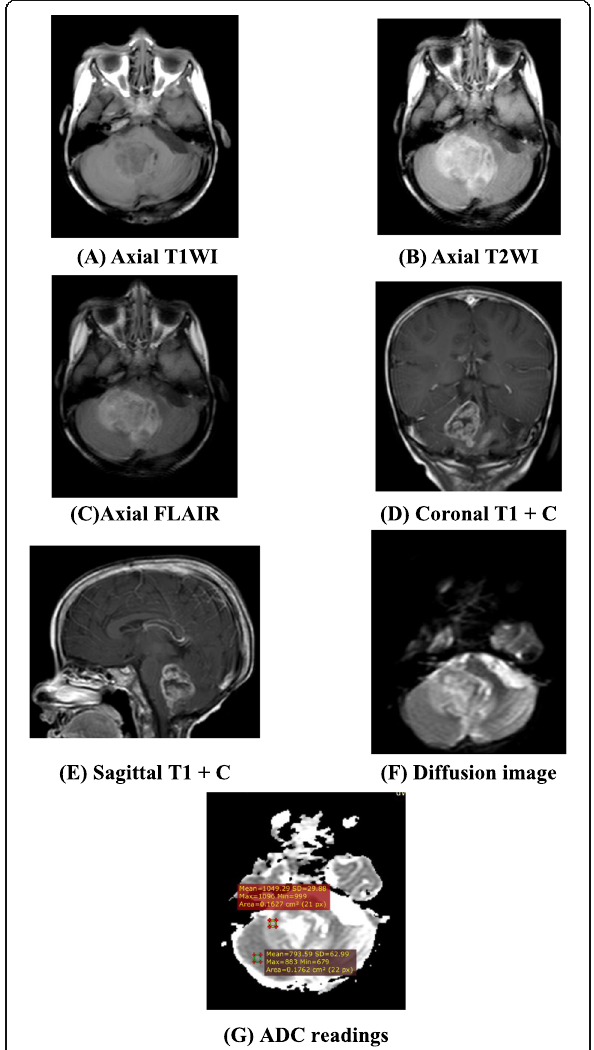
Fig. 6 An 8-year-old female patient complaining of vomiting. Axial T1 ( a ), axial T2 ( b ), axial FLAIR ( c ), coronal T1 post-contrast ( d ), sagittal T1 post-contrast ( e ) — posterior fossa intraventricular SOL seen filling the fourth ventricle and extending to the right cerebellum and left occipital lobe, measured 36 × 60 × 34 mm at its AP, width, and CC diameters. It showed heterogeneous predominantly low T1 SI ( a ), high SI at T2 WI ( b ), and FLAIR sequence ( c ) with cystic component, avid, and heterogenous enhancement after IV contrast injection ( d ), ( e ). Axial DWI ( f ), Axial ADC ( g ) — the lesion showed restricted diffusion, ADC ratio — 0.7, ADC values of the lesion (0.597, 0.594, 0.543) × 10 3 mm 2 /s, average 0.597 × 10 3 mm 2 /s, ADC value of the normal cerebellum — (0.860, 0.863, 0.869) × 103, average 0.863 × 103 mm2/s consistent